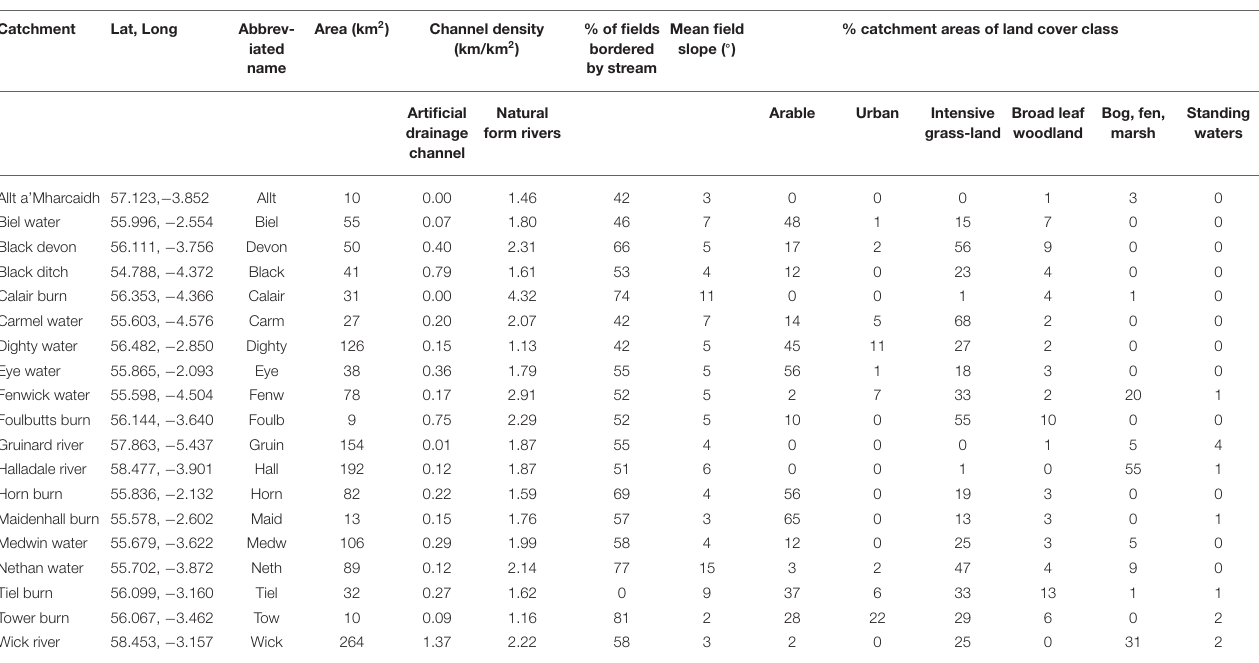
Mean field % catchment areas of land cover class Area (km 2 ) Channel density % of fields slope ( ◦ ) (km/km 2 ) bordered iated by stream name Artificial Natural Arable Urban Intensive Broad leaf Bog, fen, Standing drainage form rivers grass-land woodland marsh waters channel